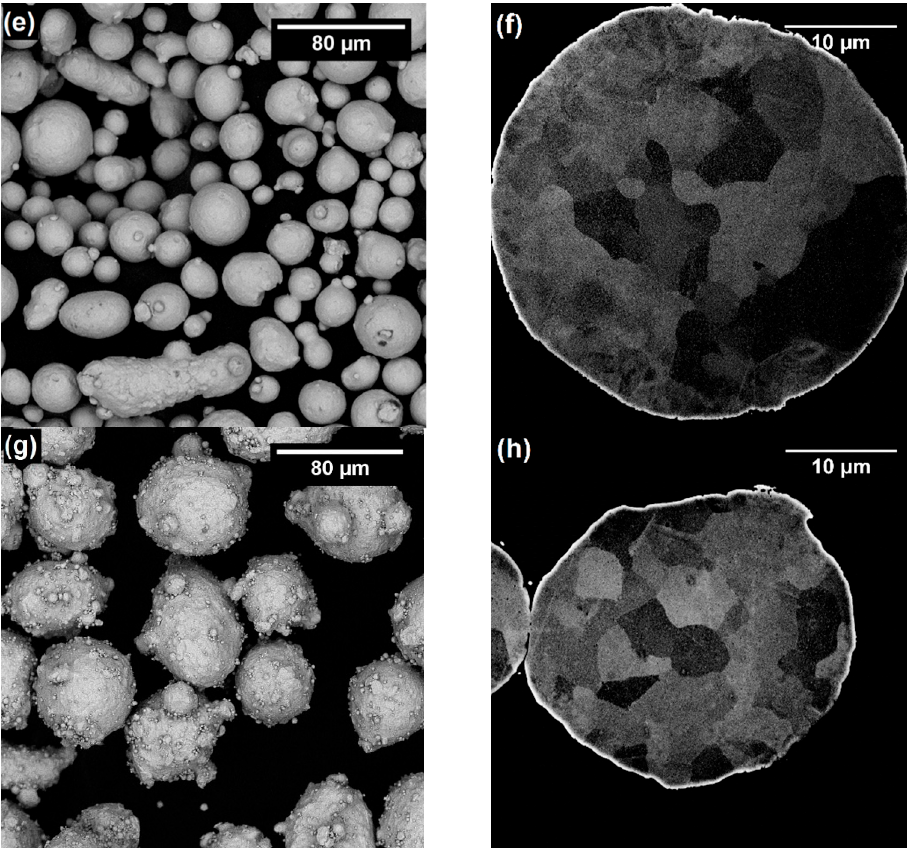
Figure 2: SEM of three dimensional and etched cross section images of powders at 1000× and 7000×, respectively. ( a , b ) 316L-CGS_1, ( c , d ) 316L-CGS_2, ( e , f ) 316L-HVOF, and ( g , h ) 316L-APS.